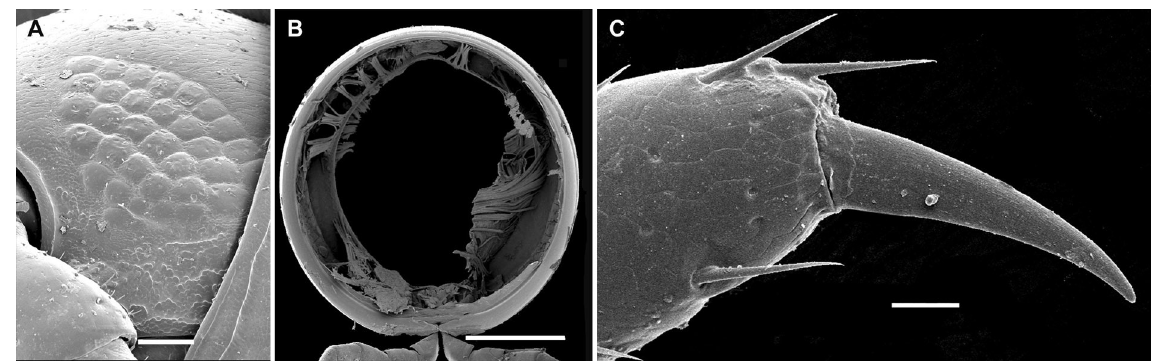
Fig. 2. Sechelleptus variabilis VandenSpiegel & Golovatch, 2007 (BE_RMCA_MYR.Dip.22883). SEM views. A . Ommatidia, lateral view. B . Transversal section of midbody, frontal view. C . Tarsal claw, lateral view. Scale bars: A = 100 µm; B = 1 mm; C = 20 µm